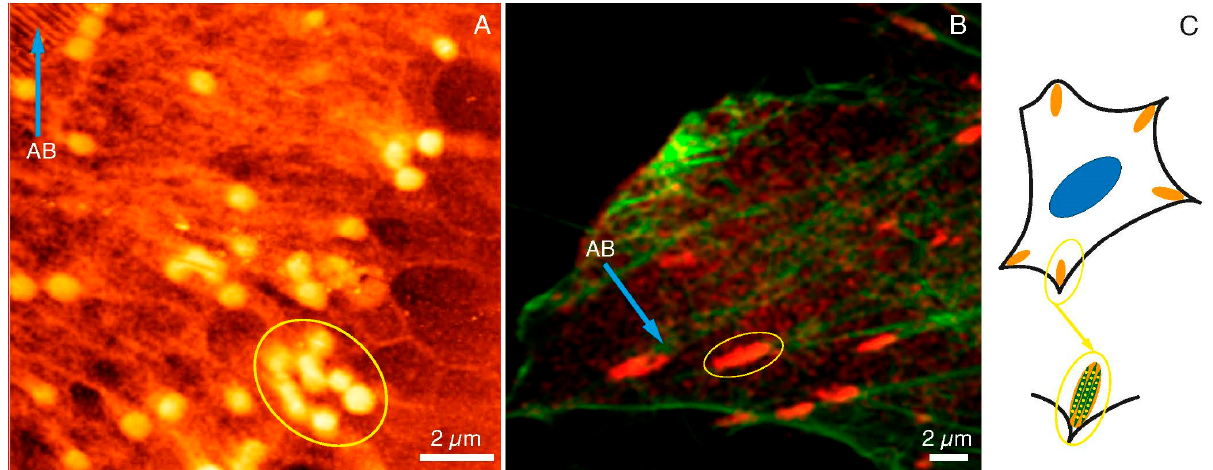
Figure 3. FAs and cytoskeleton structures under SXCM and CLSM. FAs (yellow ellipses) and actin bundles (blue arrows) as observed under ( A ) SXCM and ( B ) CLMS, ( C ) A diagram illustrating FAs structure and location within the cell. Scale bar represents 2 μ m.